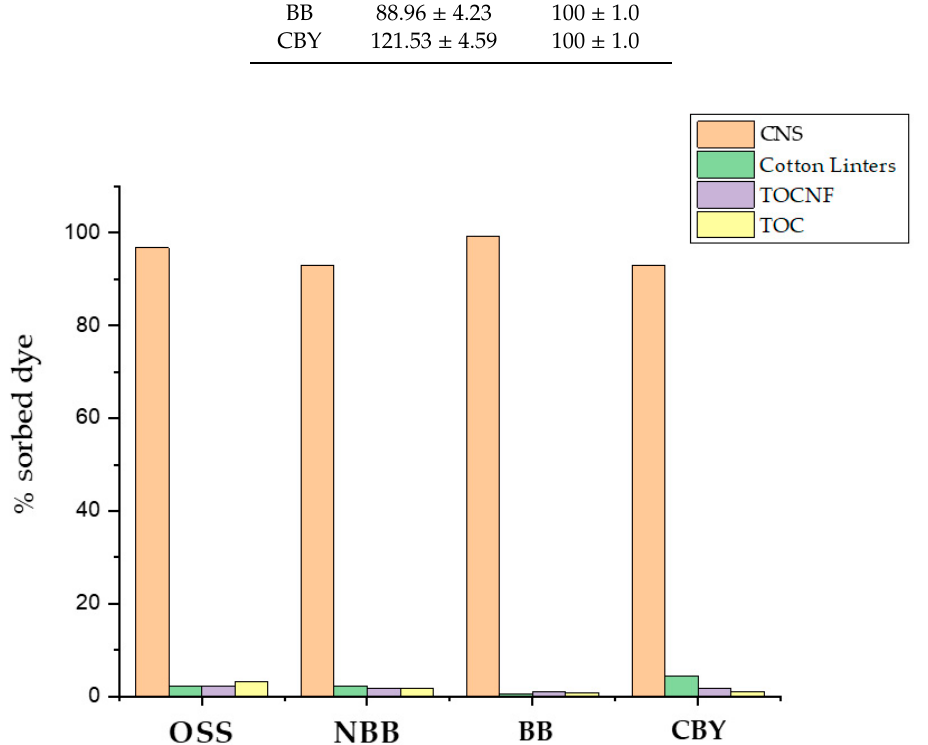
Figure 4. Comparison between sorption capacities of CNS and different cellulose forms (cotton linters, TEMPO-oxidised cellulose (TOC), TOC nanofibers (TOCNF)). Data are reported as the percentage of dye adsorbed at the end of the test with respect to the total amount of dye in solution at t 0 .